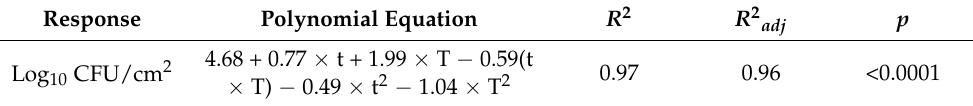
Refers to the coded values of the independent factors.